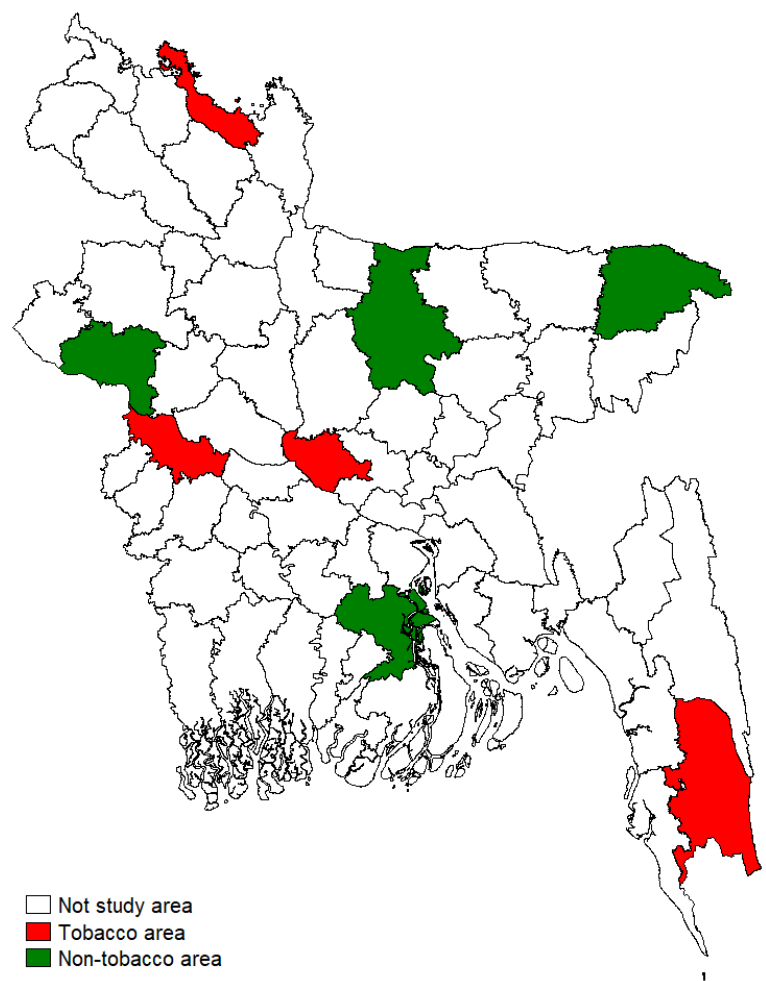
Figure A3. Study areas.